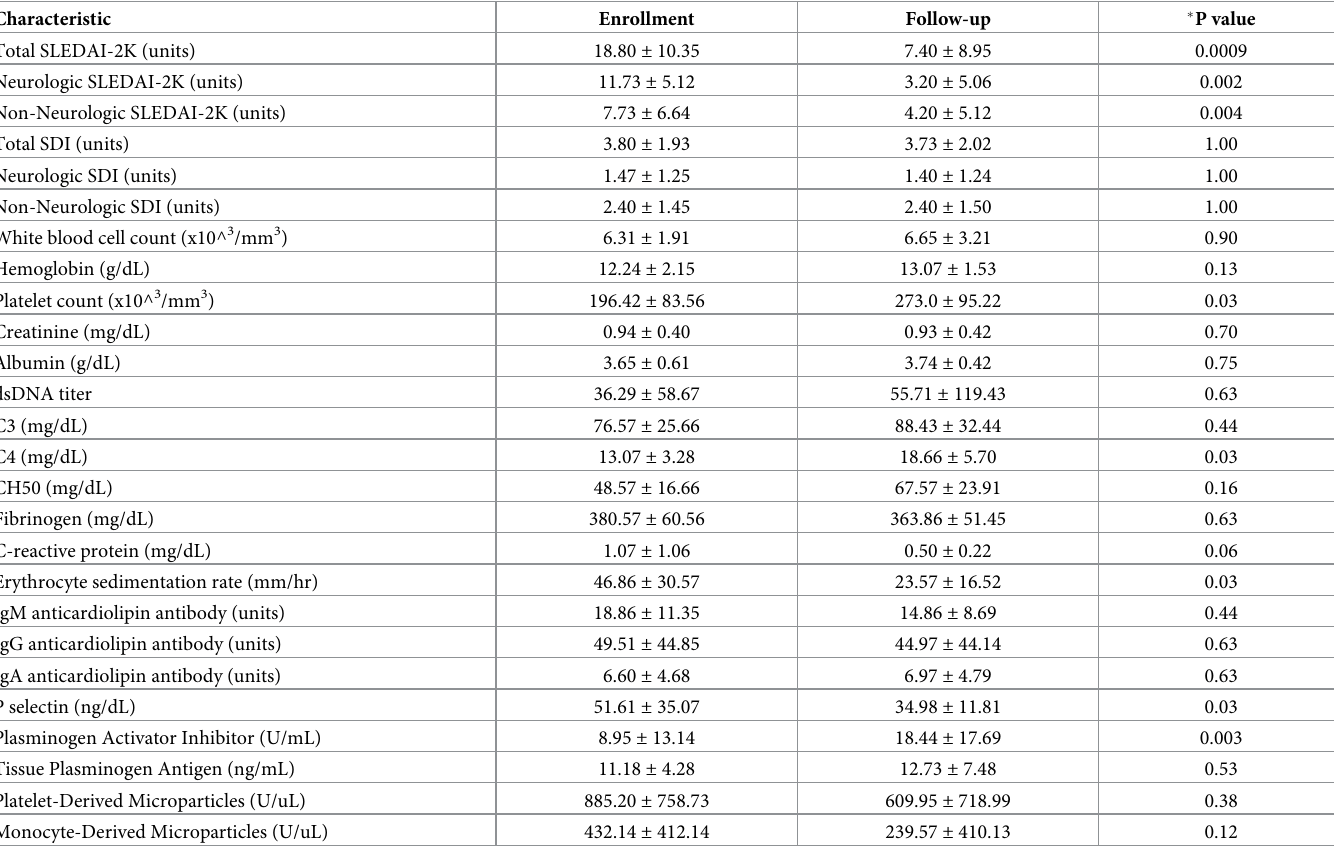
Table 2. Effect of medical therapy on clinical and laboratory parameters in SLE patients with Libman-Sacks endocarditis and cerebrovascular disease (N = 17). Characteristic Enrollment Follow-up � P value Total SLEDAI-2K (units) 18.80 ± 10.35